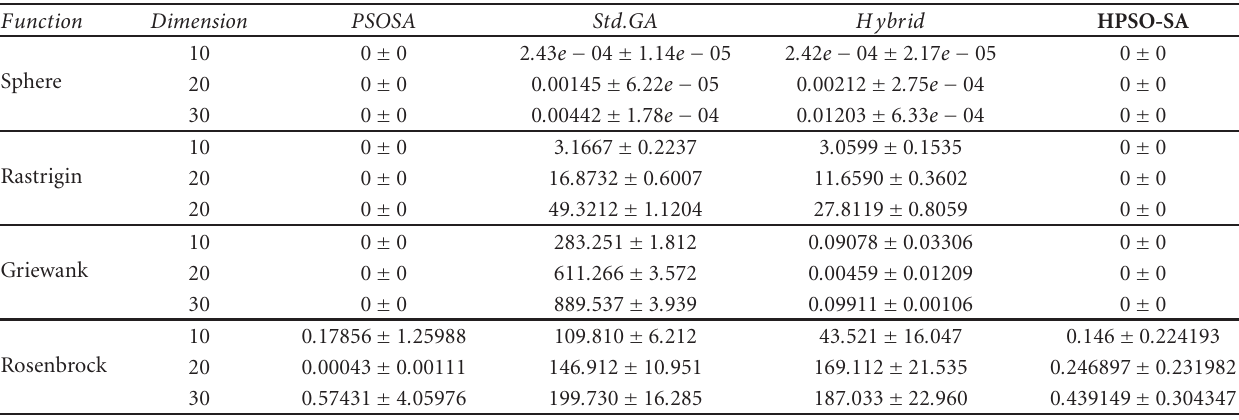
Table 5: Performance comparison between PSOSA, Sid.GA, Hybrid and HPSO-SA for benchmark functions [9].